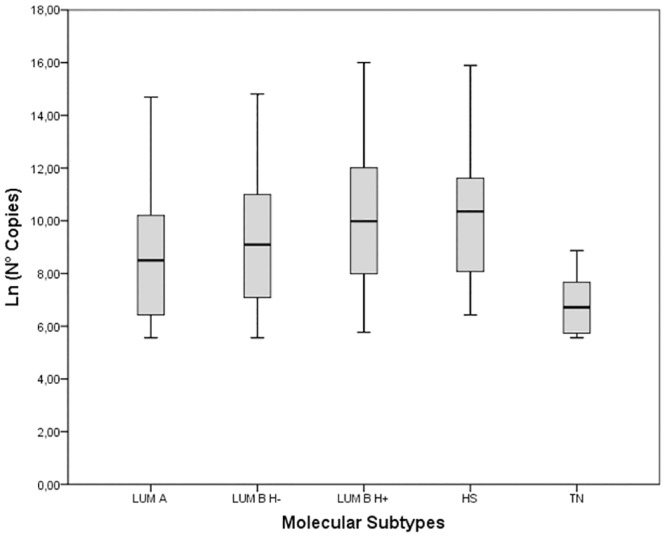
Cytokeratin 19 mRNA copy number distribution according to molecular subtypes.Box Plot showing the distribution of cytokeratin 19 mRNA copy number in the five molecular subtypes. The Kruskall-Wallis test indicates a significant difference among groups (p<0.0001). Data are expressed on a log scale for presentation purposes.